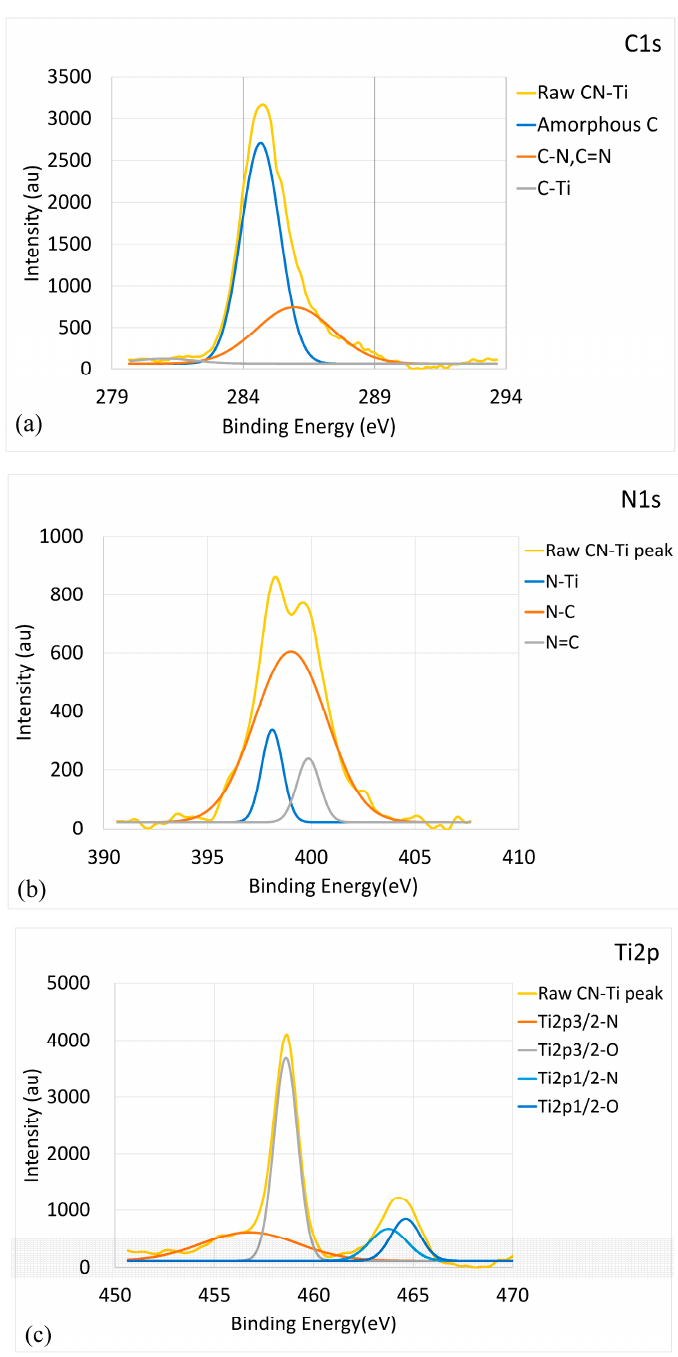
Figure 2. Bonding energy of CNx-Zr coating characterized by XPS: ( a ) C1s XPS raw and deconvoluted spectra; ( b ) N1s XPS raw and deconvoluted spectra; and ( c ) Zr3d raw and deconvoluted spectra.